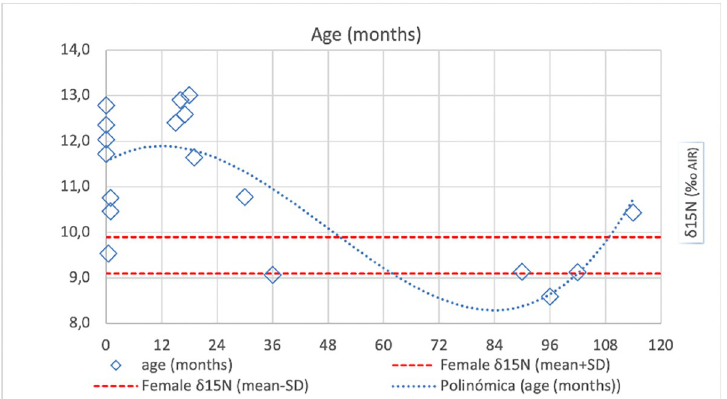
Fig 6. Plot of human bone collagen δ 15 N values from Vila de Madrid pre-adults plotted against age in